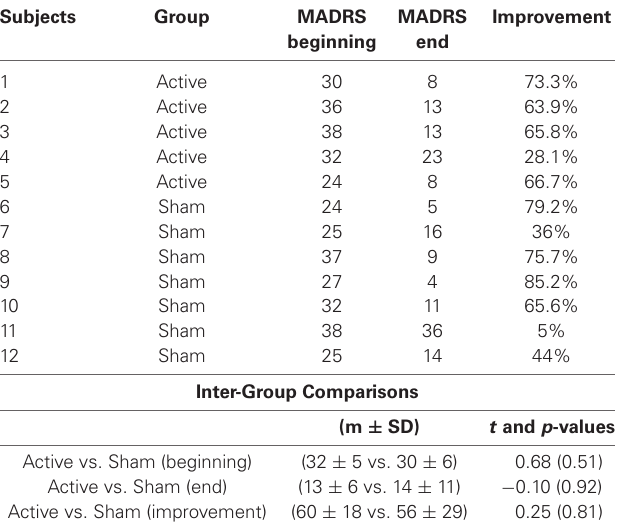
Table 1 | Individual MADRS scores arranged by Group (active vs. sham) and day of treatment (beginning vs. end) and intergroup comparisons